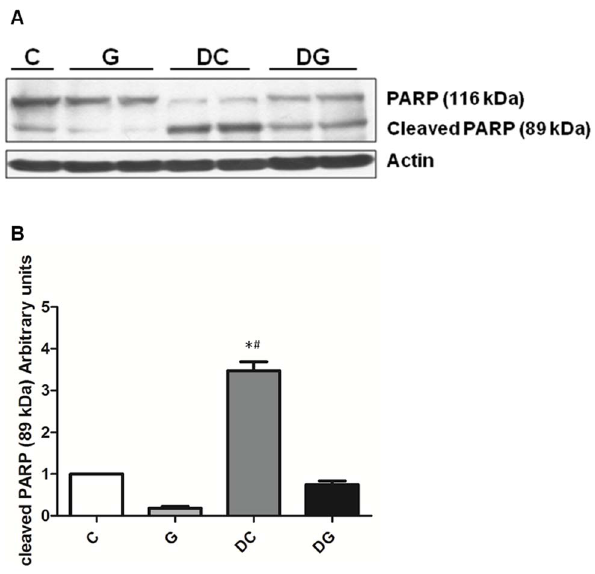
Figure 6. Protein levels of PARP and cleaved PARP in colon tissues. A: protein expressions of PARP and cleaved PARP. Whole-tissue lysates were analyzed by immunoblotting, and b -actin was used as a loading control. B: densitometric analysis of the blot corrected by the protein loading control. Results of the densitometric analysis are shown as the mean 6 SEM. *Significantly differs from the C group. # Significantly differs from the DG group (P , 0.05).